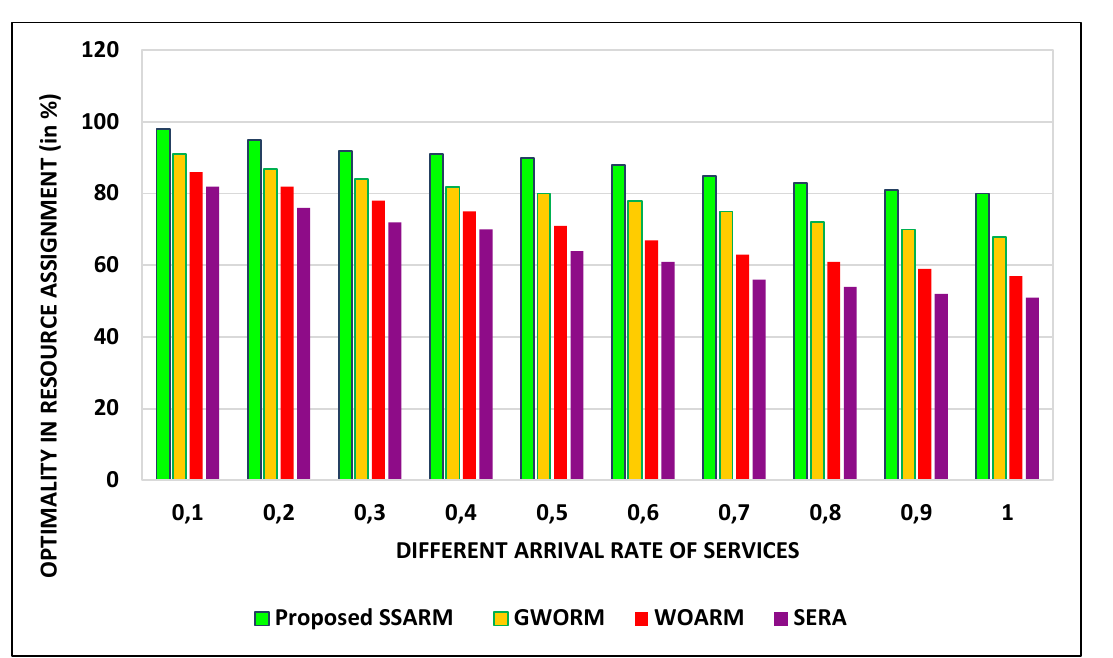
Figure 4. Proposed SSARM-Optimality in Resource Assignment with Different Service Arrival